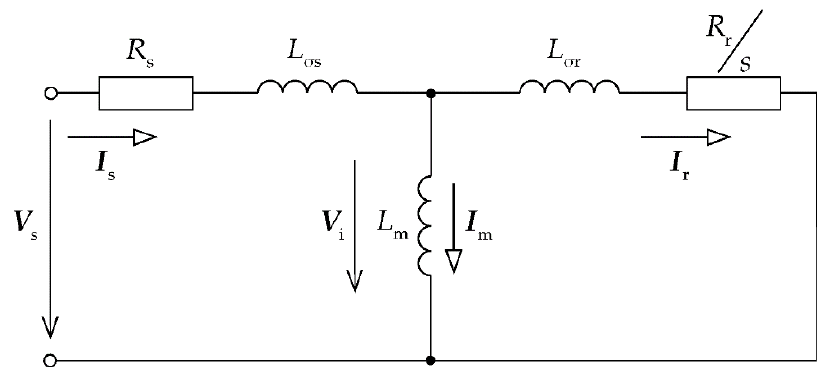
Figure 2. T-equivalent circuit of an induction machine.